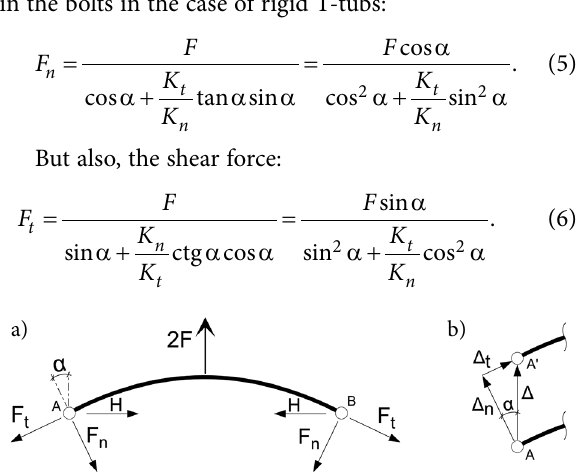
c)Figure 2. General calculation scheme for: a – equilibrium; b –